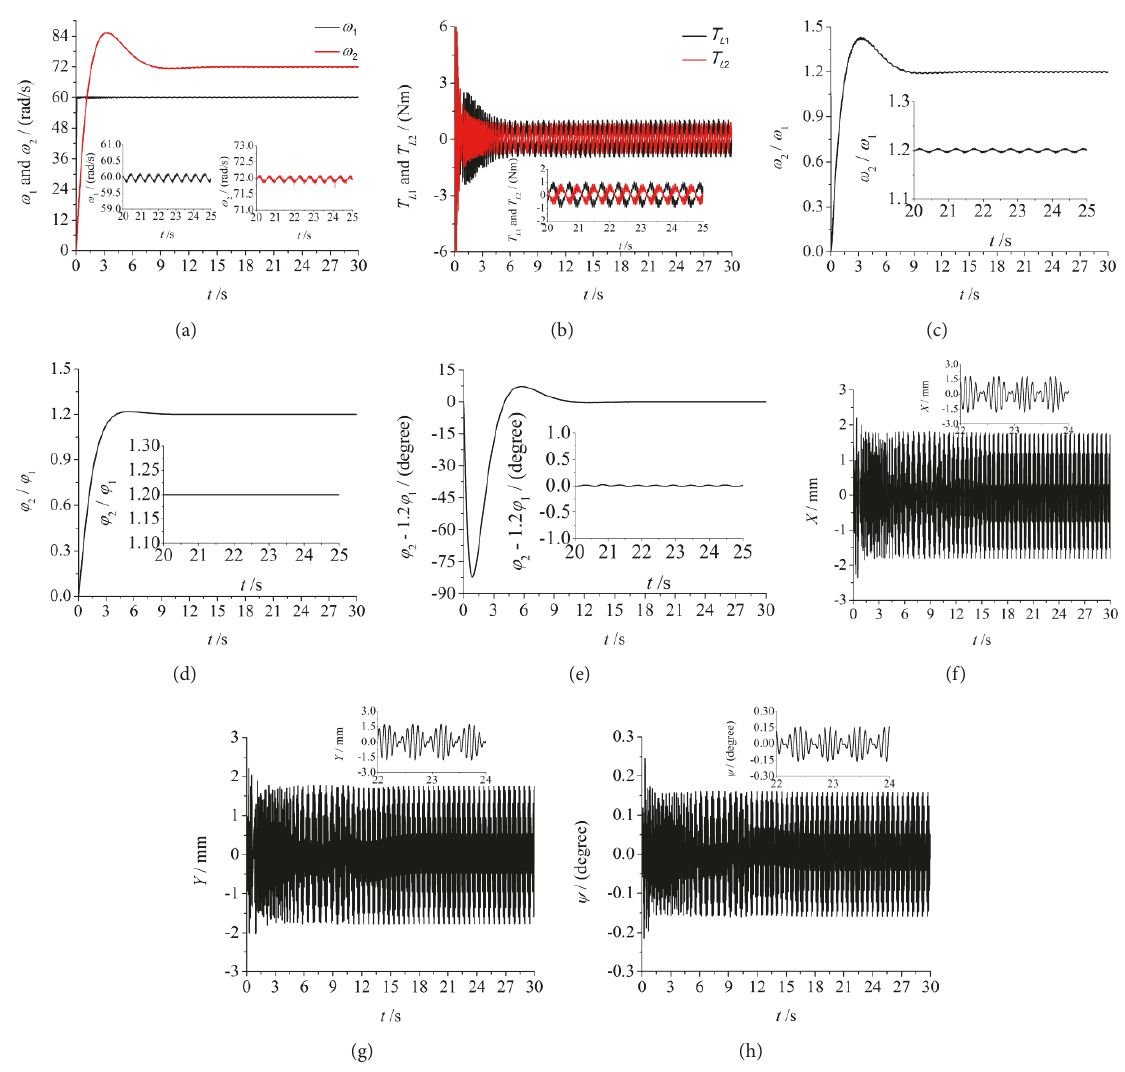
Figure 7: Multifrequency controlled synchronization on the situation 𝑛 = 1.2 , where 𝛼 0 = 0 , with 𝛼 0 being the initial phase difference. (a) Speed of the motors; (b) load torque; (c) speed ratio; (d) phase ratio; (e) phase difference; (f) response of the 𝑥 direction; (g) response of the 𝑦 direction; (h) response of the 𝜓